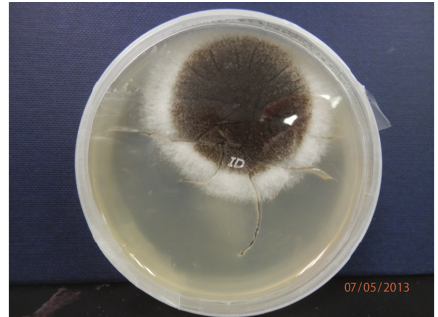
Figure 1: The surface colonies of the fungi on cultured plate consist of a compact white yellow basal felt covered by a dense layer of dark brown to black conidial heads and white on the reverse.